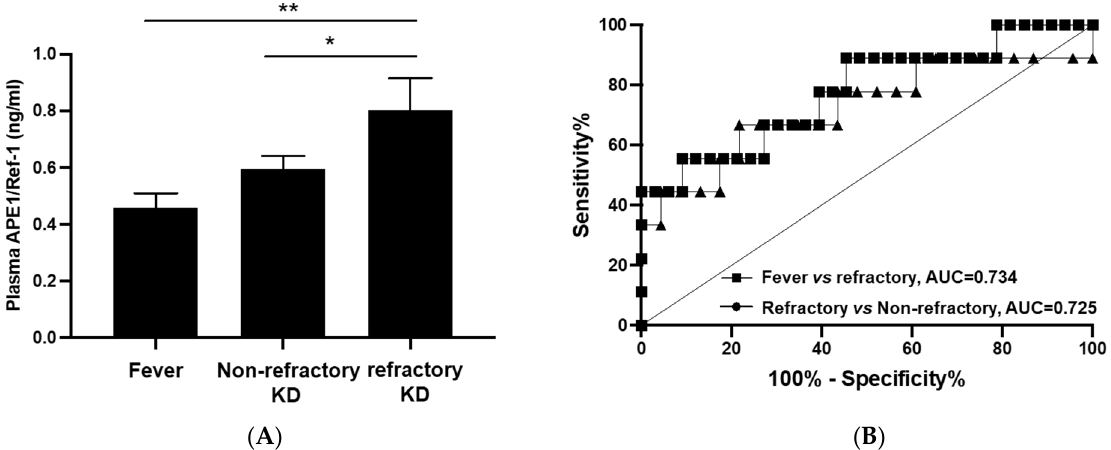
Figure 2. APE1/Ref-1 levels between the fever, non-refractory KD, and refractory KD groups. ( A ) APE1/Ref-1 levels between the fever and refractory KD groups showed a significant difference (** p = 0.011) and those between the non-refractory and refractory KD also showed a significant difference (* p = 0.046) ( B ) The ROC curve of APE1/Ref-1 predicting refractory KD, (Fever vs. refractory KD, AUC = 0.734, Refractory vs. non-refractory, AUC = 0.725).